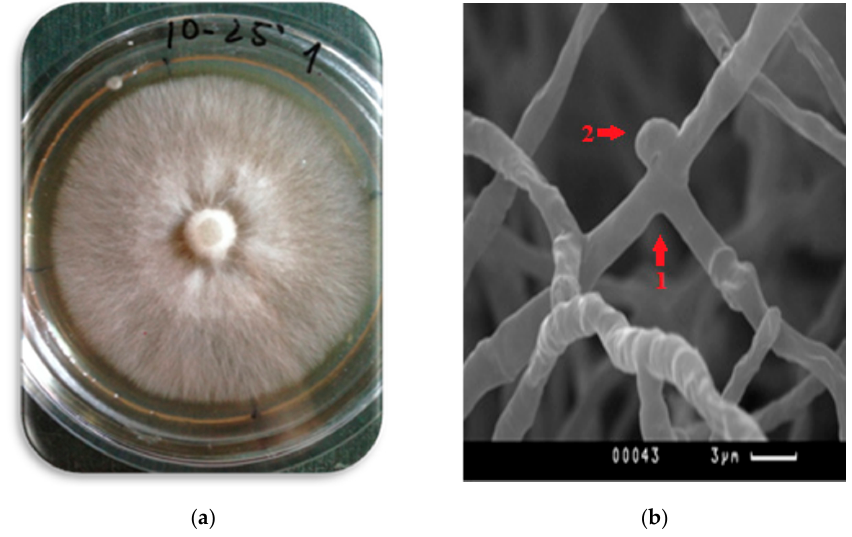
Figure 1. Colonies of P. eryngii ( a ) and an SEM image of P. eryngii mycelium ( b ): 1—branching hyphae; 2—clamp connection.